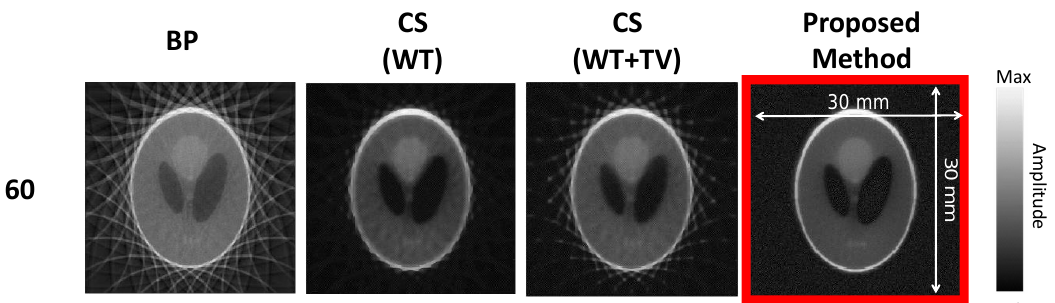
Figure 5. Results of reconstruction algorithms on the Shepp–Logan synthetic phantom for 60 view angles and different reconstruction algorithms.